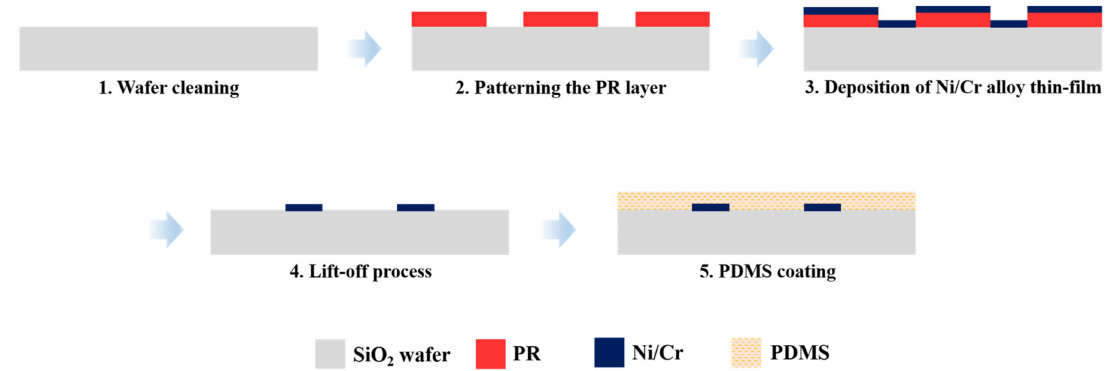
Figure 3. Process of Ni/Cr alloy thin-film-based microconstruction fabrication.